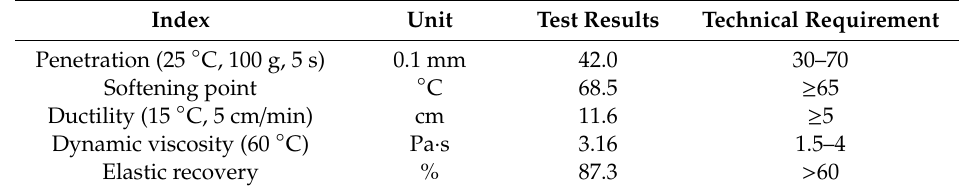
Table 3. Technical indexes of rubber asphalt.